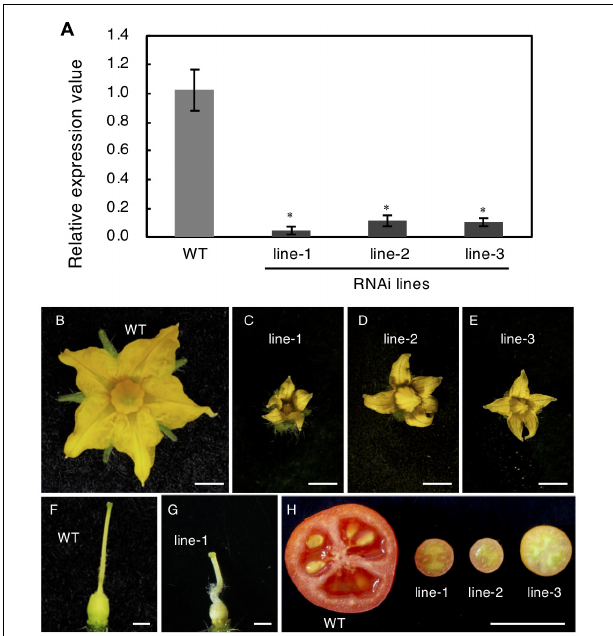
FIGURE 7 | Knock-Down of SPFF gene expression in RNAi transgenic tomato lines. (A) Expression analysis of SPFF gene in the leaves of WT and RNAi lines. The floral morphology of WT (B) and the RNAi plants line-1 (C) , line-2 (D) and line-3 (E) . The pistil morphology of WT (F) and the RNAi plant line-1 (G) . (H) Pollinated WT (left) and parthenocarpic fruit in the RNAi lines (right). Bars are 2 mm (B–E) , 1 mm (F,G) and 1 cm (H) . At least three biological repetitions were performed and their mean values with SE are shown. Asterisks indicate significant difference between WT and RNAi plant (Student t test, p <